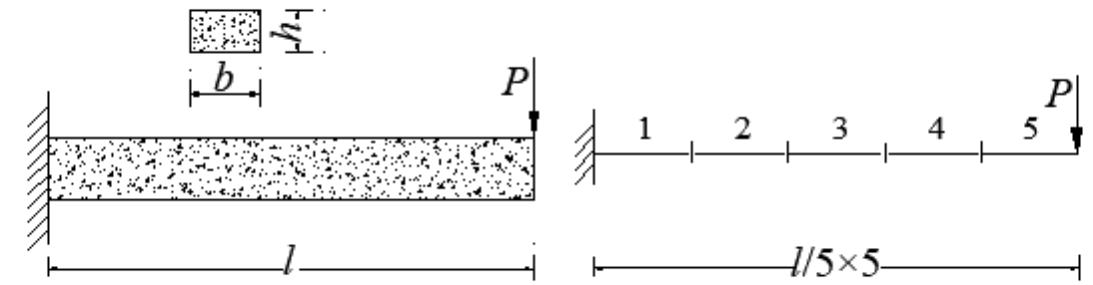
Figure 2. Cantilever beam subjected to external load effect ( P ).